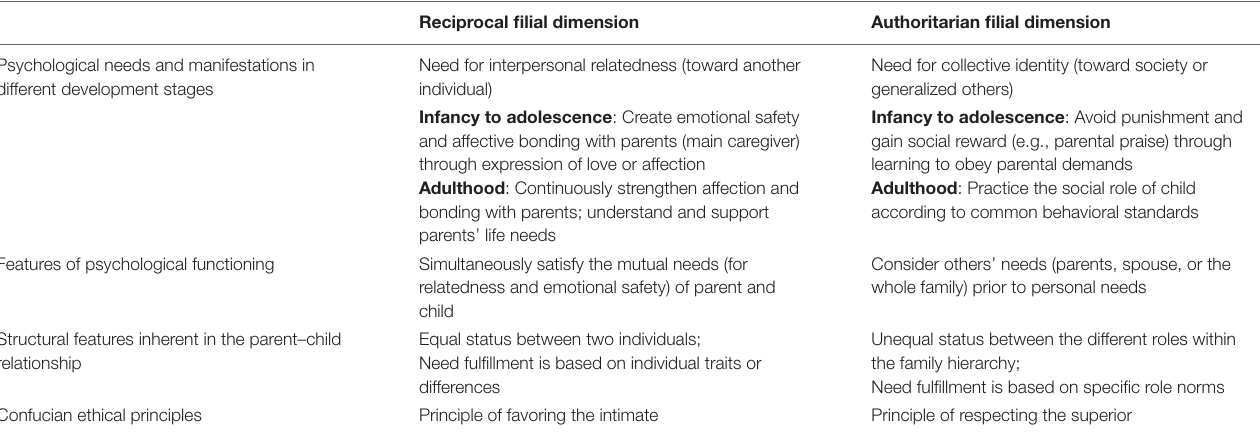
TABLE 1 | The dual filial piety model: psychological schemas for interaction with parents. Reciprocal filial